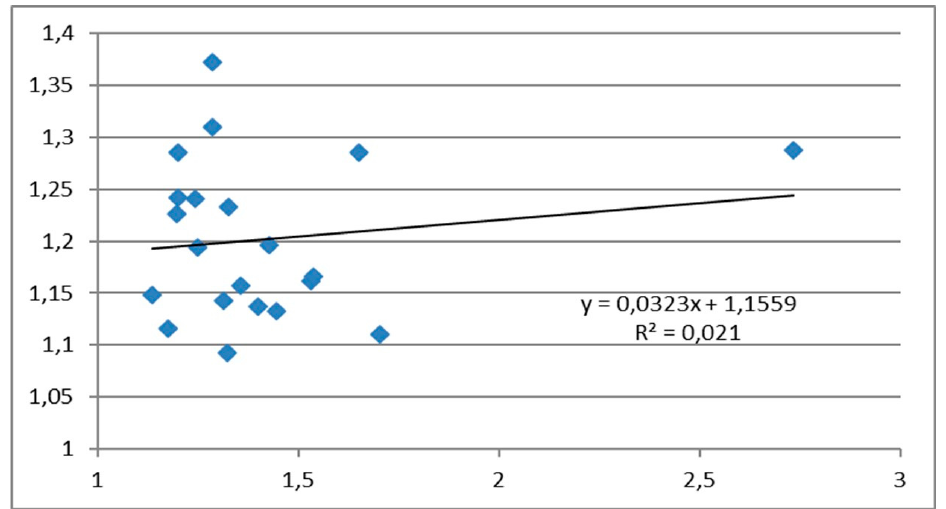
Figure 3. Correlation between HMDR clin and HMDR echo in patients with morbid obesity.